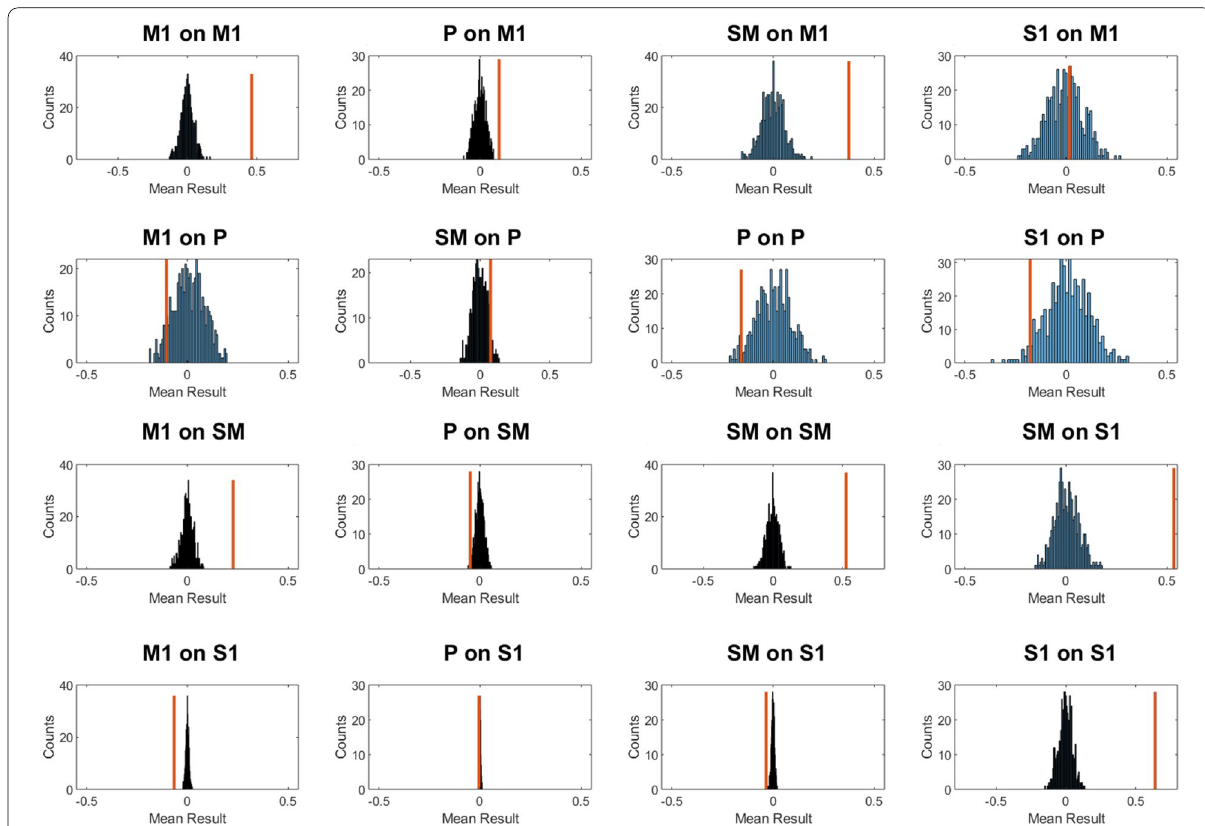
Fig. 5 Mean conditional dependencies between real fMRI data computed through the particle filter: in blue, the histogram of mean values obtained on time-series randomly permuted in time, while the red line shows the corresponding mean value obtained from non-permuted time-series. Many of these values lie well outside of the null distribution, therefore their value reflects the effective mean causal interaction and it is not produced by